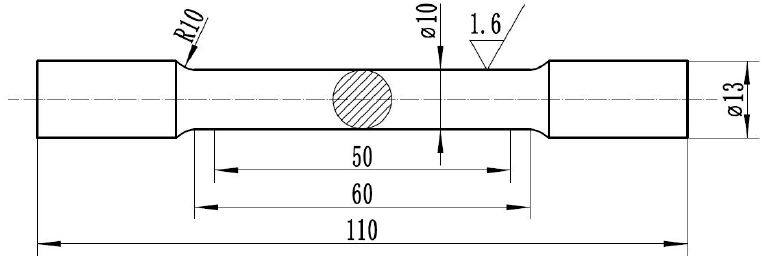
Figure 1. Drawing of tensile specimens (unit: mm).